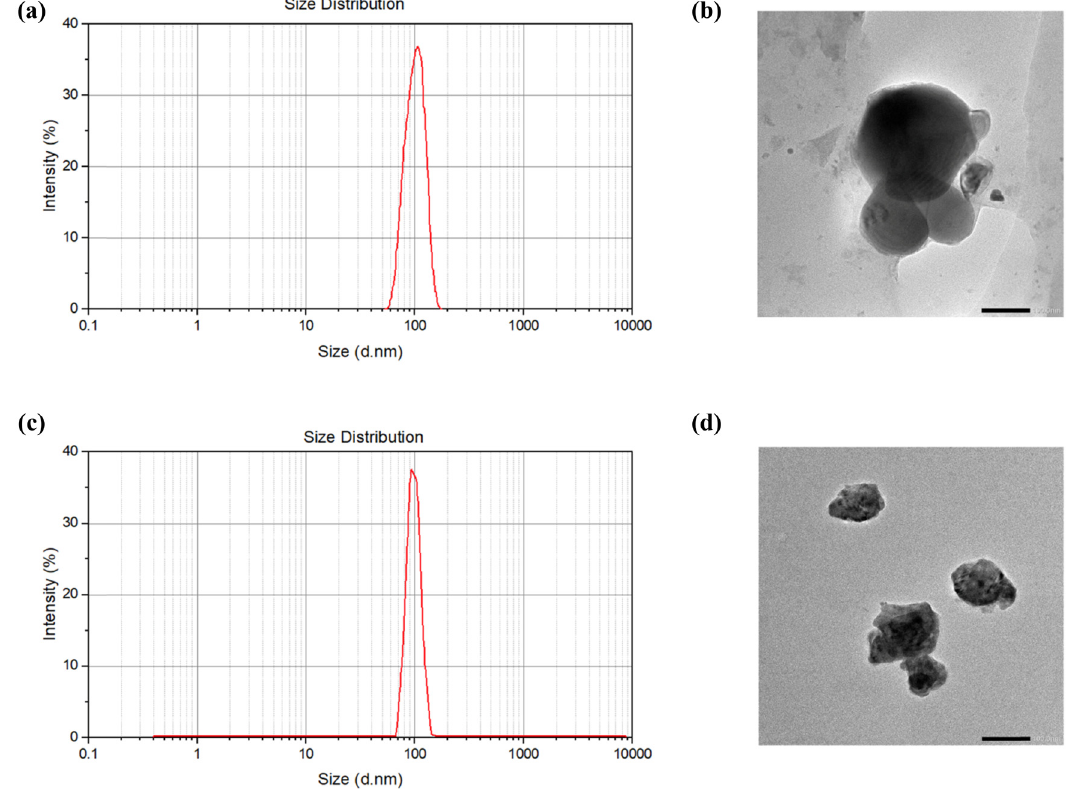
Figure 2: Size distribution of ( a ) blank liposomes and ( c ) MuA - loaded liposomes; TEM images of ( b ) blank liposomes and ( d ) MuA - loaded liposomes ( scale bar 100 nm ) .